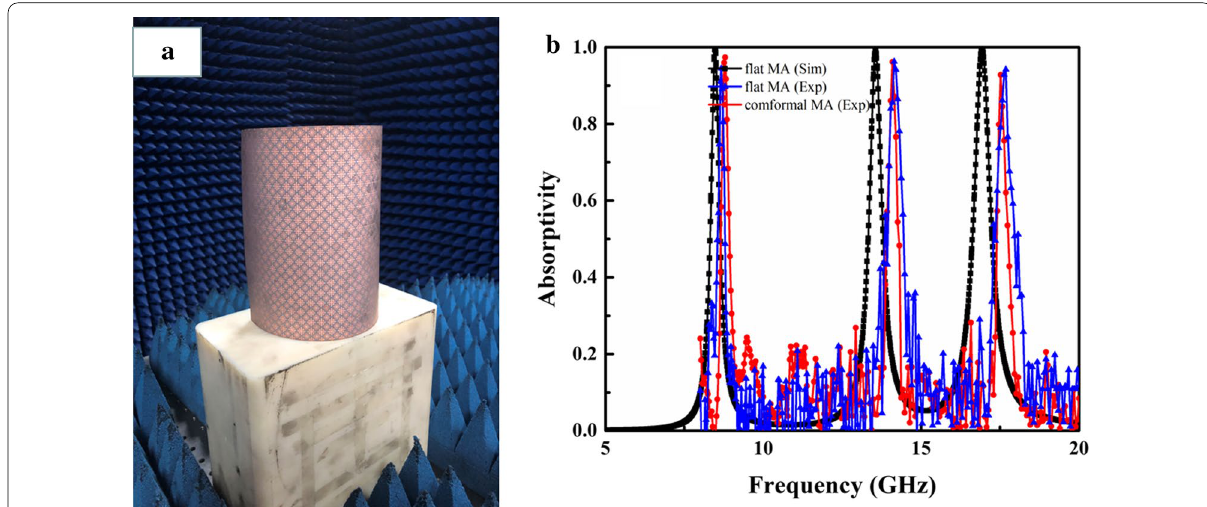
Fig. 11 a Flexible absorber attached to a cylinder. b Absorption spectra of the flat and conformal